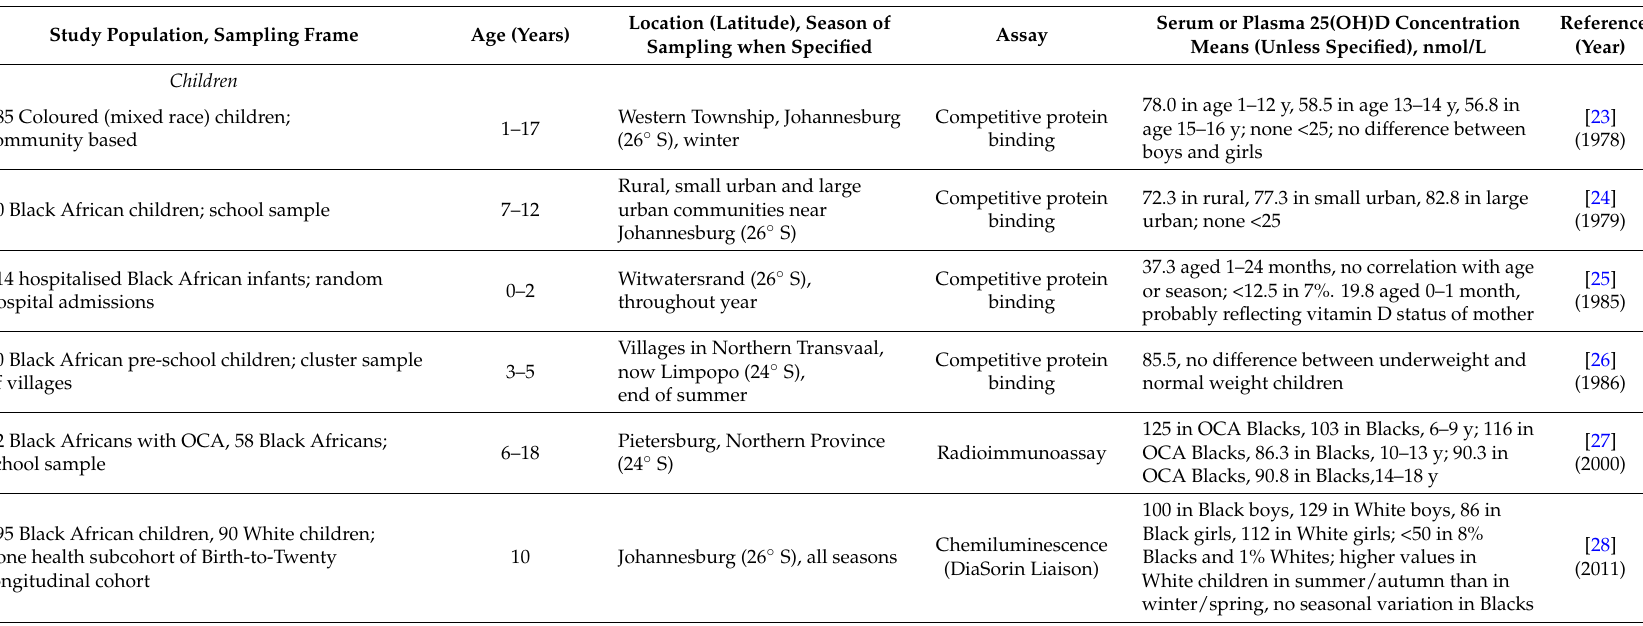
Table 2. Studies assessing vitamin D status, as 25-hydroxyvitamin D [25(OH)D] levels, in various populations of children, adults and the elderly in South Africa (listed chronologically by year in each